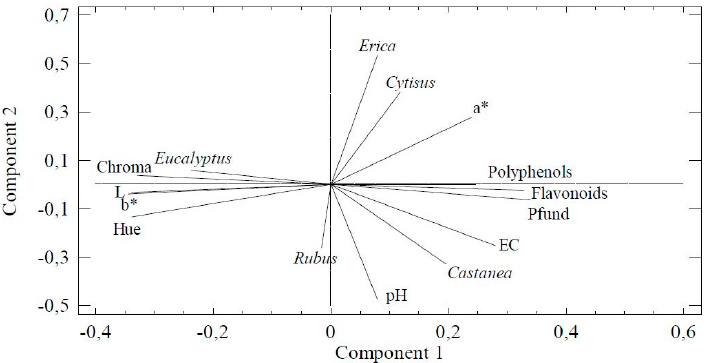
Figure 3. Plot of the first two components according to the variables in introduced in principal component analysis (PCA).